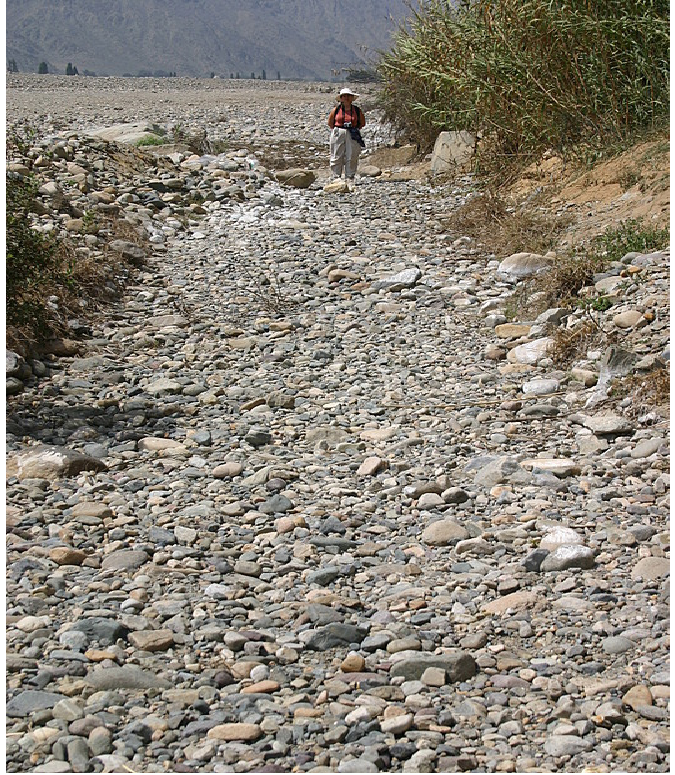
Figure 14. Interior channel from upper reaches of the Supe River leading river water to valley bottom agricultural and reservoir areas.